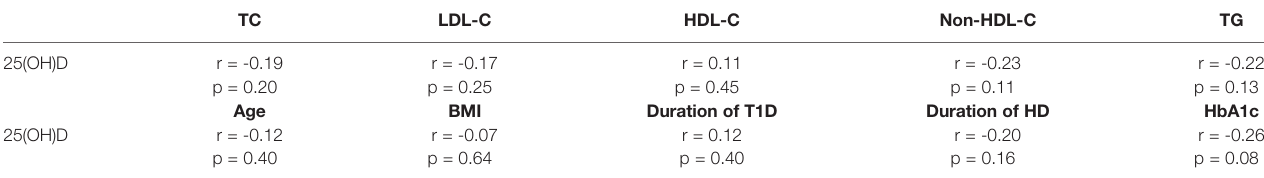
TABLE 2 | Spearman correlation analysis testing the correlation between 25(OH)D concentration and selected laboratory and clinical